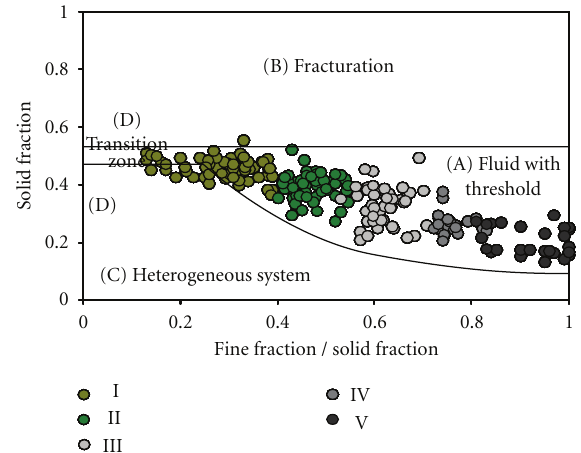
Figure 6: Conceptual scheme for the five types of MOb sediments.